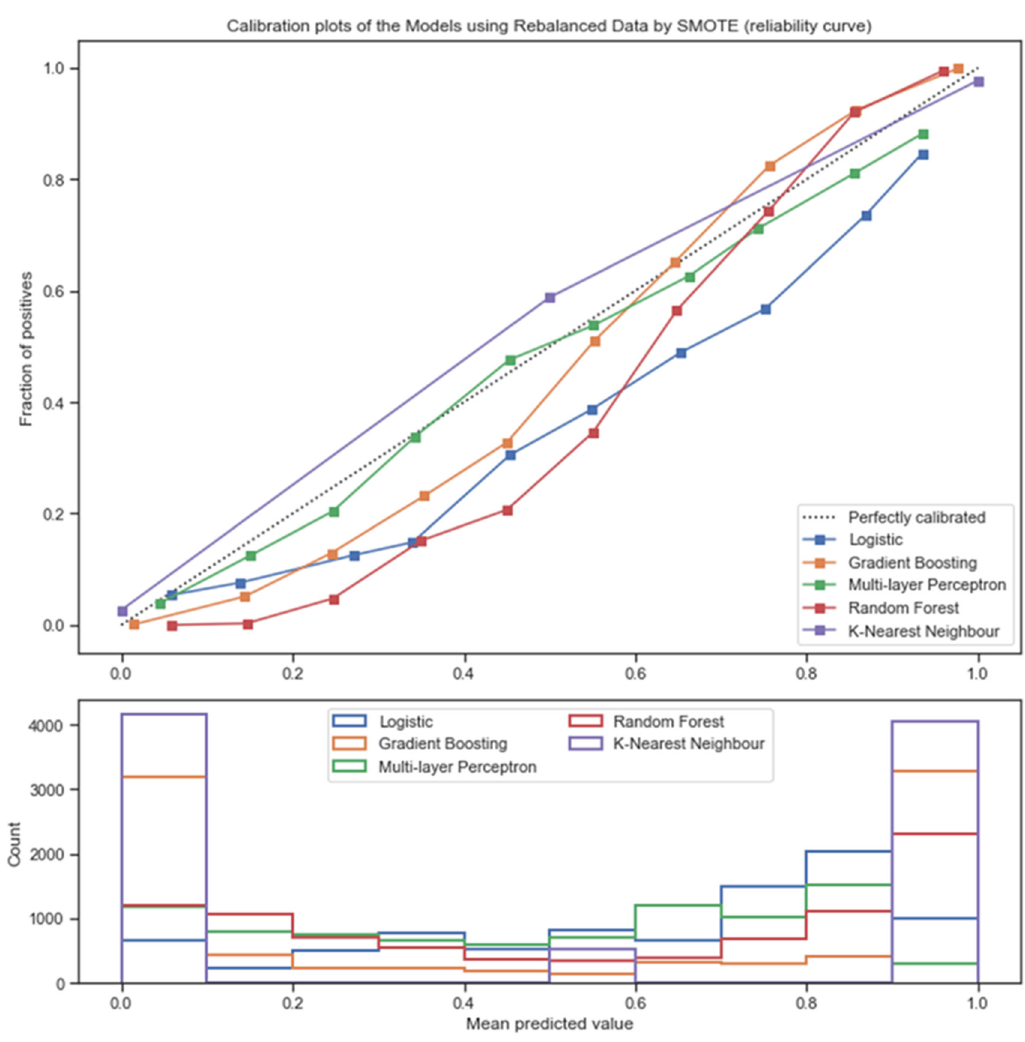
Figure 3. Calibration plot of the rebalanced learning classifiers .